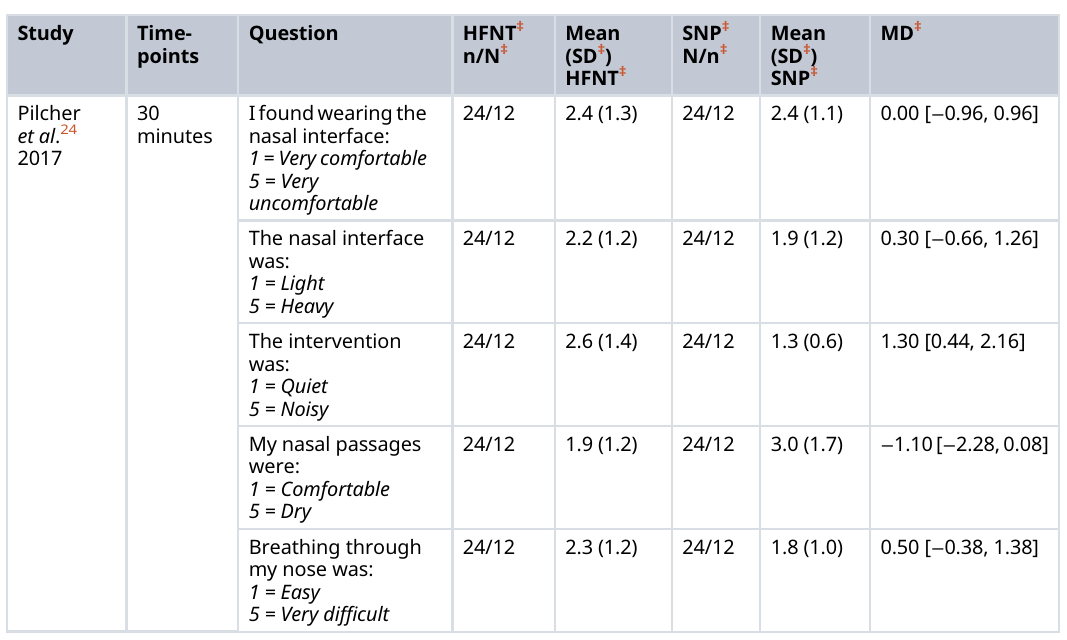
Table 6. Comfort score using Likert scale * (RCT comparing HFNT vs SNP). 24